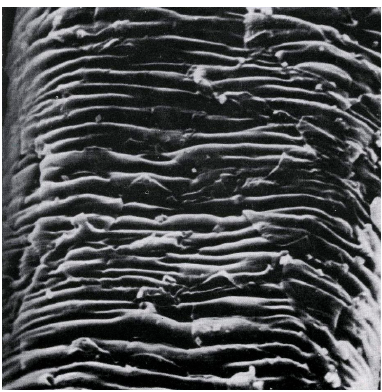
Figure 25. Scanning electron micrograph of supercontracted mohair.